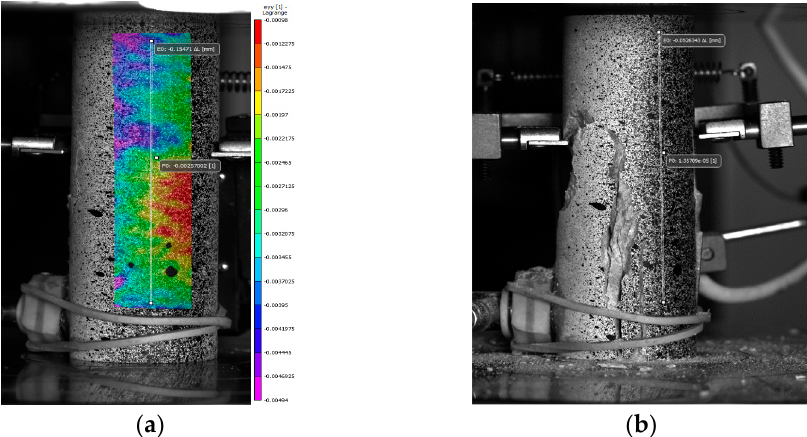
Figure 7. Images of the rock sample 14 with a speckle structure painted at the one side of the sample taken using the Vic 3D strain field registration system: ( a ) during the test; ( b ) after the test.